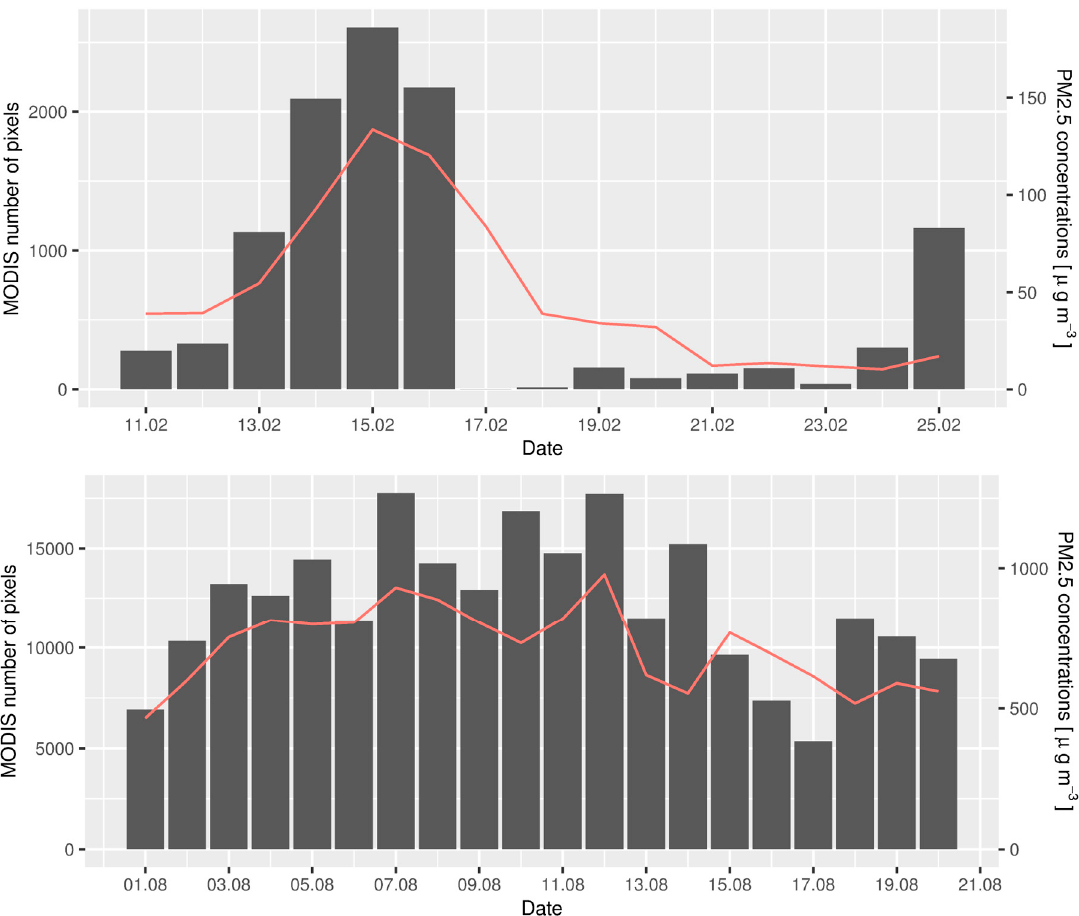
Figure 1. Moderate Resolution Imaging Spectrometer (MODIS) data availability with quality flag 2 or 3 over inner domain (Poland, 4 km × 4 km) for the winter 2017 (upper plot) and summer 2015 (lower plot) episodes. Mean observed (43 stations for winter, 34 stations for summer) particular matter (PM2.5, diameter less than 2.5 µm) concentrations are shown by the red line.